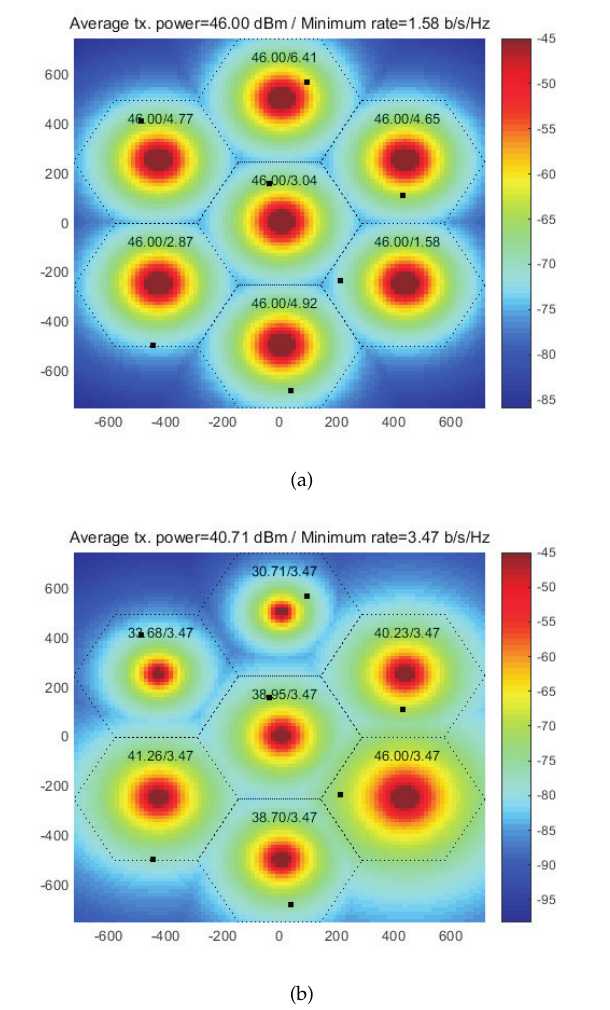
Figure 3. Distribution of received signal strength in two dimensions: ( a ) maximum equal power allocation; and ( b ) proposed TPC